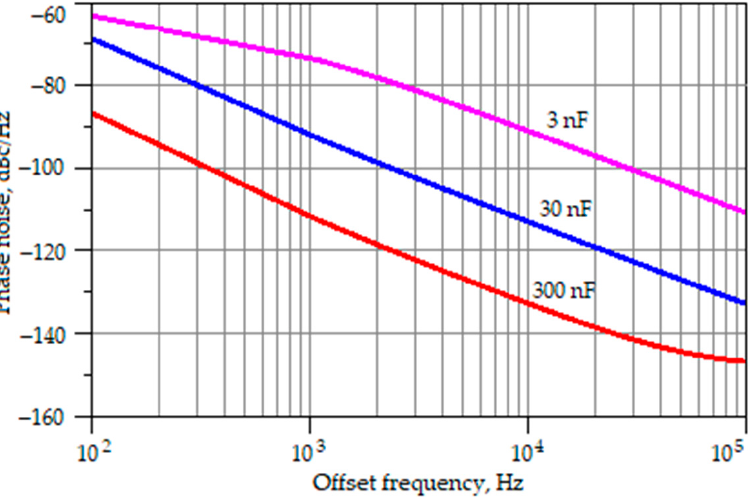
Figure 26. Phase noise versus offset frequency for the VCO with multiple-output improved Wilson current mirror when V d = 12 V, R L = ∞ , and C a = 6 pF; C b = 3 nF—purple curve, C b = 30 nF—blue curve, C b = 300 nF—red curve.